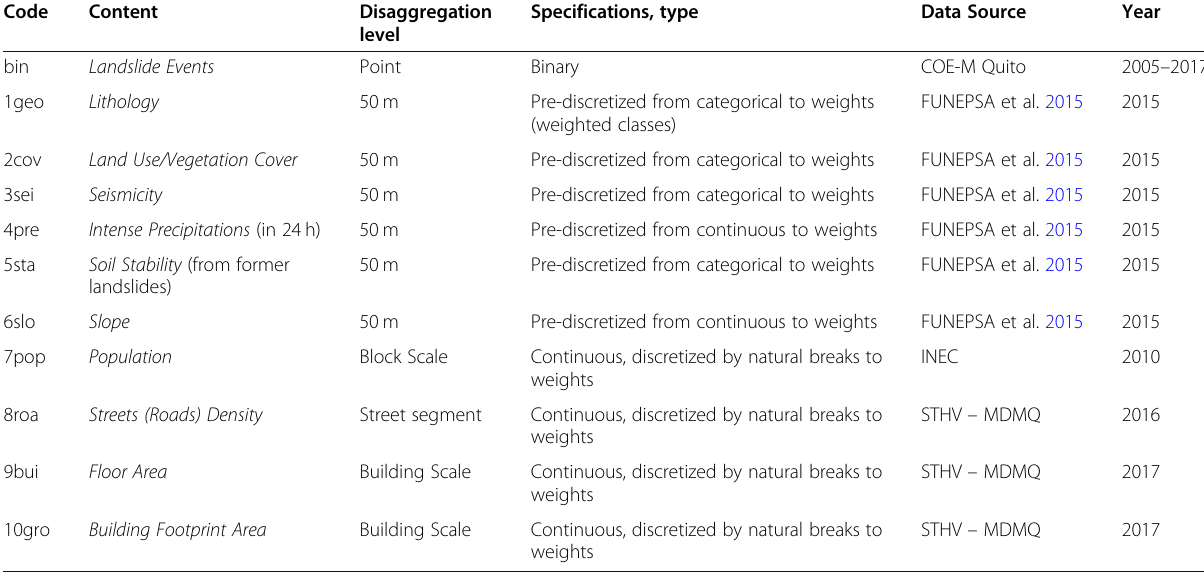
Table 2 Input data for landslide susceptibility mapping in Quito